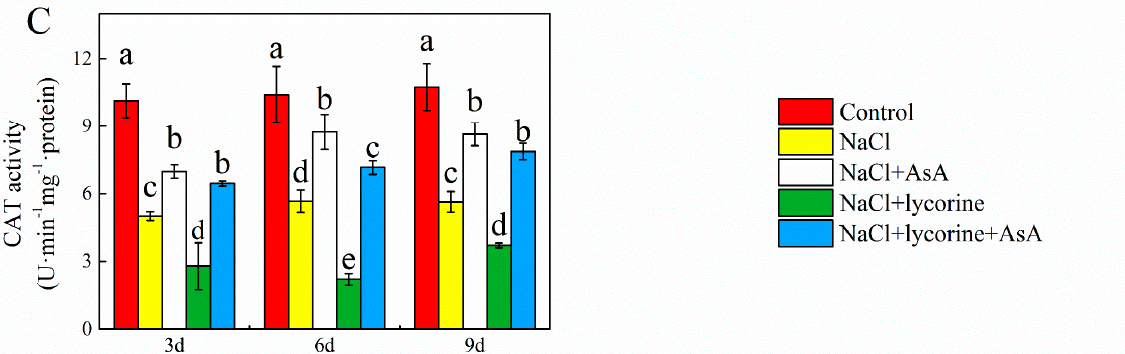
Figure 9. Values of superoxidase dismutase (SOD) ( A ), peroxidase (POD) ( B ), and catalase (CAT) ( C ) activity in leaves of salt-stressed tomato seedlings with or without exogenous reduced ascorbic acid (AsA) and lycorine (AsA synthesis inhibitor) spraying. Abbreviations 3d, 6d, and 9d represent the third, sixth, and ninth day after treatment, respectively. Control, no added NaCl and sprayed with distilled water; NaCl, added 100 mmol·L –1 NaCl and sprayed with distilled water; NaCl + AsA, added 100 mmol·L –1 NaCl and sprayed with 0.5 mmol·L –1 AsA; NaCl + lycorine, added 100 mmol·L –1 NaCl and sprayed with 0.25 mmol·L –1 lycorine; NaCl + lycorine + AsA, added 100 mmol·L –1 NaCl and sprayed with 0.25 mmol·L –1 lycorine plus 0.5 mmol·L –1 AsA. Values are means ± SD ( n = 3). Values with a different letter within a sampling date are significantly different ( p < 0.05).